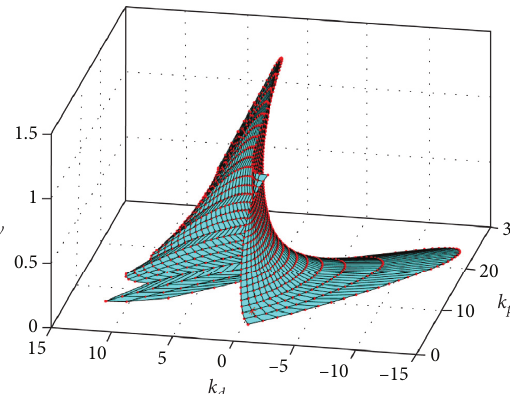
Figure 5: Maximum stability surface.